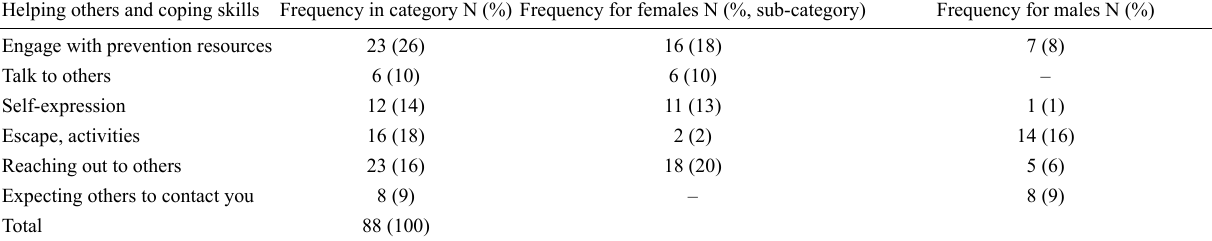
Table 3. Attitudes towards helping and coping by